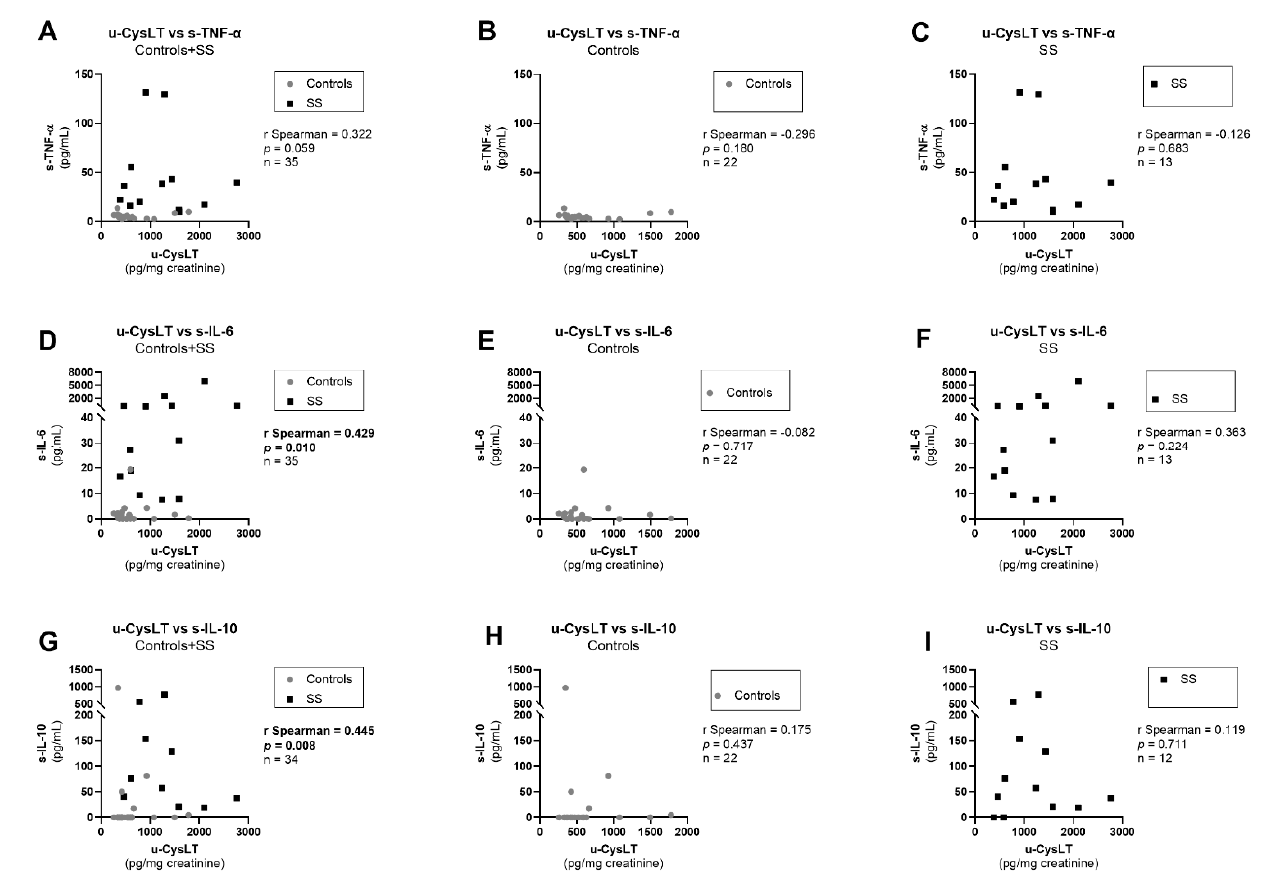
Figure 5. Correlations between u-CysLT and cytokines at admission in the overall study population and separately in controls and in SS: ( A ) u-CysLT vs. s-TNF- α in Controls + SS; ( B ) u-CysLT vs. s-TNF- α in Controls; ( C ) u-CysLT vs. s-TNF- α in SS; ( D ) u-CysLT vs. s-IL-6 in Controls + SS; ( E ) u-CysLT vs. s-IL-6 in Controls; ( F ) u-CysLT vs. s-IL-6 in SS; ( G ) u-CysLT vs. s-IL-10 in Controls + SS; ( H ) u-CysLT vs. s-IL-10 in Controls; ( I ) u-CysLT vs. s-IL-10 in SS. s-IL-6, serum interleukin 6; s-IL-10, serum interleukin 10; s-TNF- α , serum tumor necrosis factor alpha; u-CysLT, urinary cysteinyl leukotrienes. The values of u-CysLT were corrected for the respective urinary creatinine concentrations.